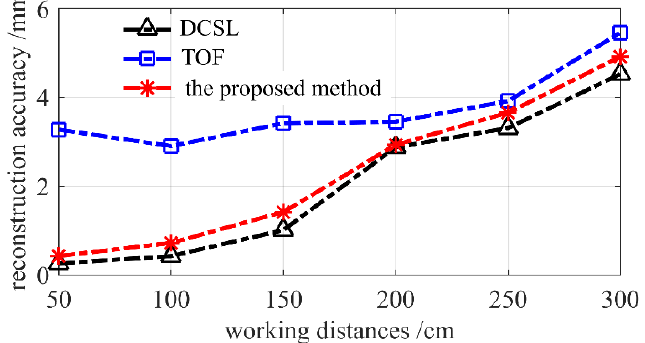
Figure 10. Reconstruction accuracy comparison of TOF, DCSL and the proposed method in different working distances.